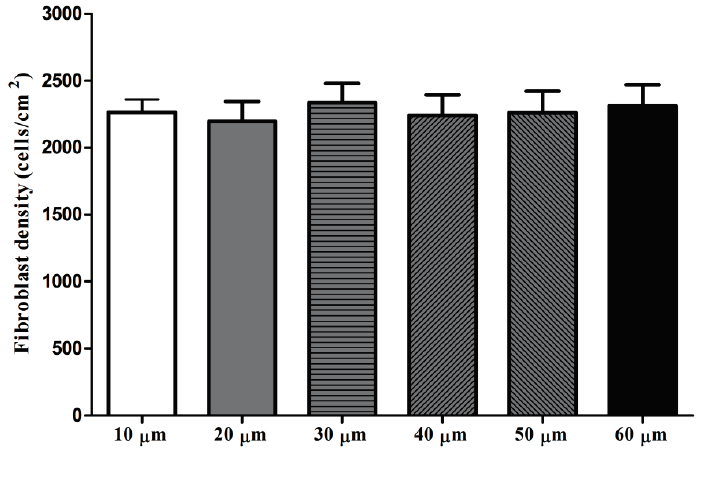
Figure 2. Fibroblast adhesion on microporous structures with different micropore diameters after 4 h of culture.